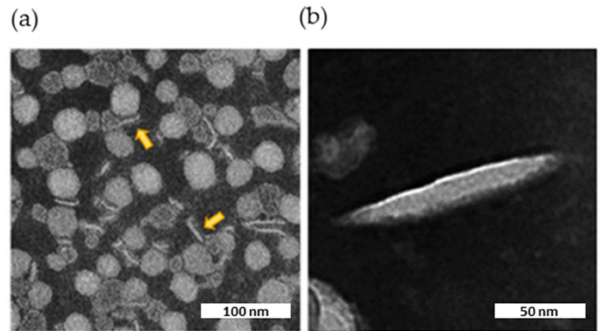
Figure 7. TEM image of the nanodiscs. Characteristic negative stain electron microscopic image of nascent HDL, along with two expanded views of the indicated insets. The scale bar corresponds to 100 or 50 nm. ( a ) Nanodiscs viewed laterally are indicated by yellow arrows. ( b ) Enlargement of a nanodisc decorated with